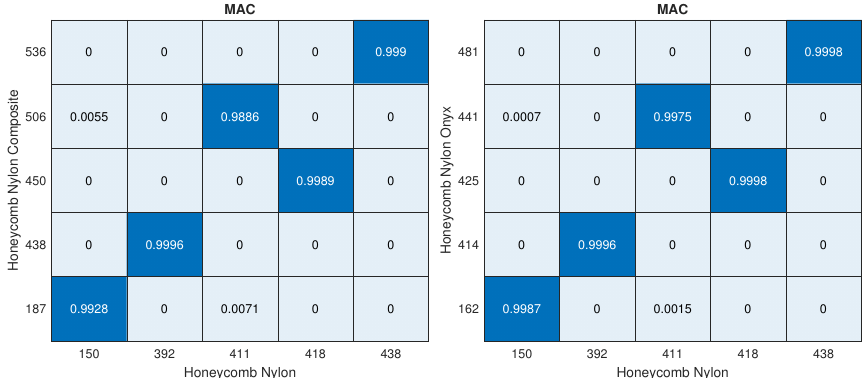
Figure 8. MAC results of honeycomb lattice structure: